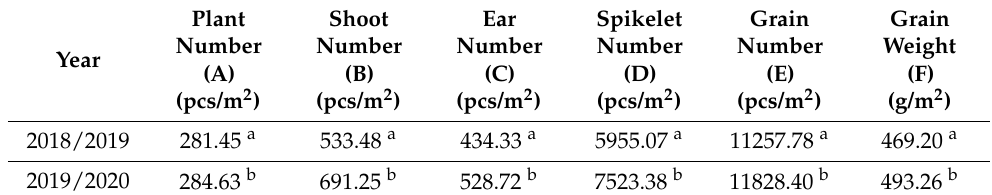
Table 12. Changes in winter wheat ( Triticum aestivum L.) yield components (A, B, C, D, E, F) in the study years.